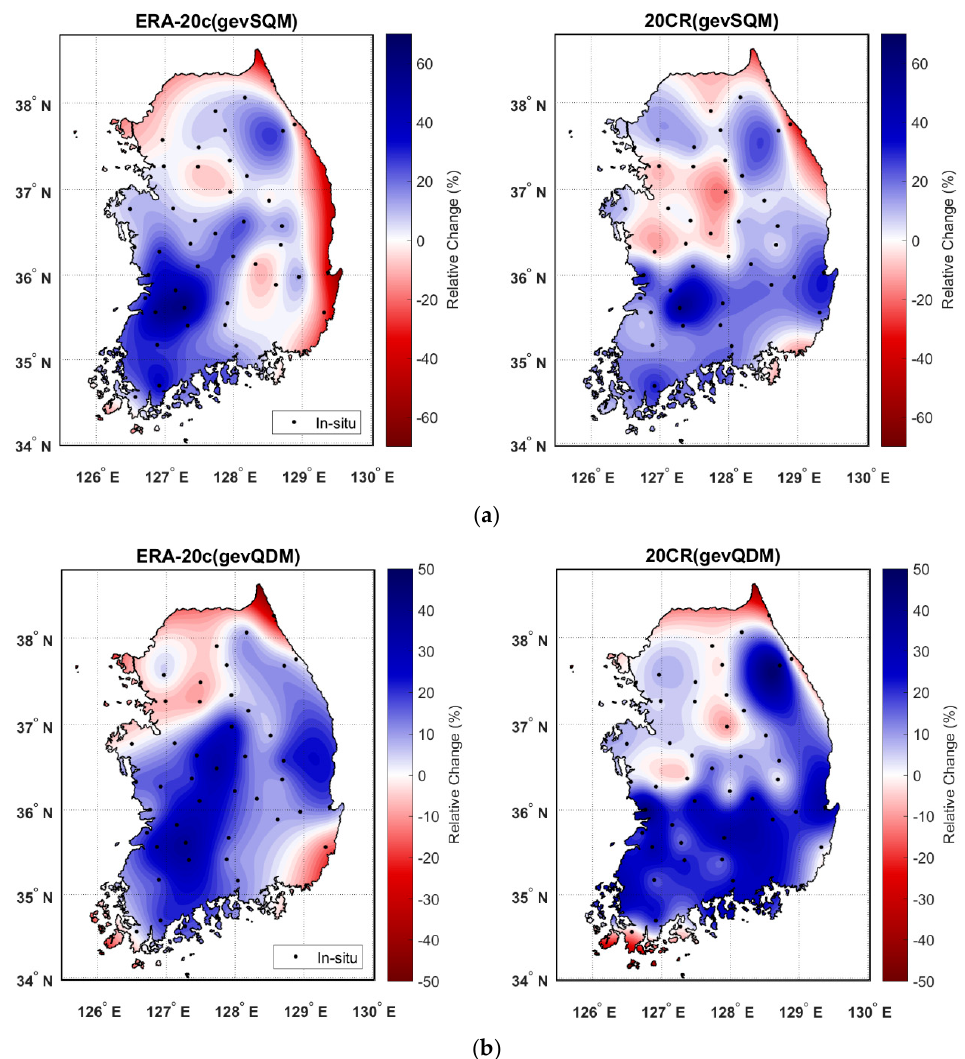
Figure 11. Relative change (%) of design rainfalls with 100 ‐ year return period between stationary condition and nonsta ‐ tionary condition. ( a ) indicates the relative change for the bias corrected AMRs by gevSQM, while ( b ) means the results condition and nonstationary condition. ( a ) indicates the relative change for the bias corrected for the bias corrected AMRs by gevQDM.